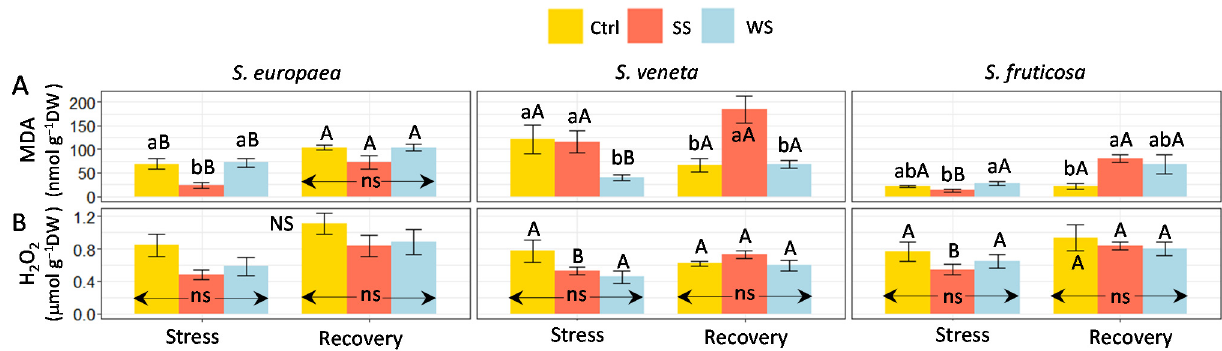
Figure 6. Effect of 30 days of stress treatments (Stress) followed by watering with non-saline water for 15 days (Recovery) on shoot concentration of ( A ) Malondialdehyde (MDA) and ( B ) hydrogen peroxide (H 2 O 2 ) in the three halophytes. Ctrl, control; SS, salt stress (watering with 700 mM NaCl); WS, water stress (complete withholding of irrigation). For each species and sampling (Stress or Recovery), different lowercase letters over the bars indicate significant differences between treatments (Ctrl, SS, and WS), at p ≤ 0.05; ns: non-significant. Different uppercase letters indicate significant differences between the two samplings (Stress and Recovery) for each species and treatment, at p ≤ 0.05; NS: non-significant. Vertical bars indicate standard error ( n = 4).